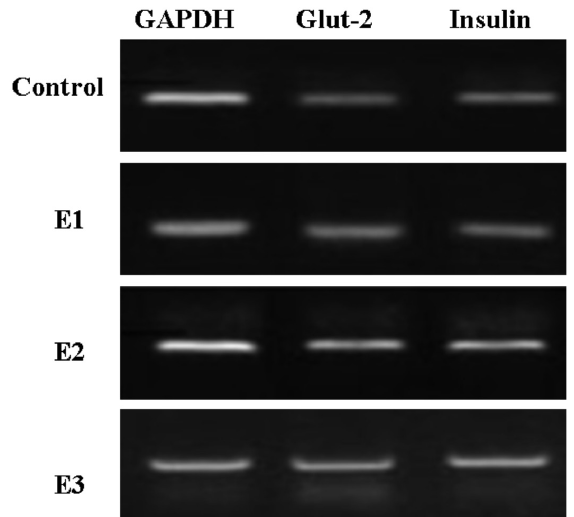
FIGURE 5 - The expression of insulin and Glut-2 genes in various groups by RT-PCR method is